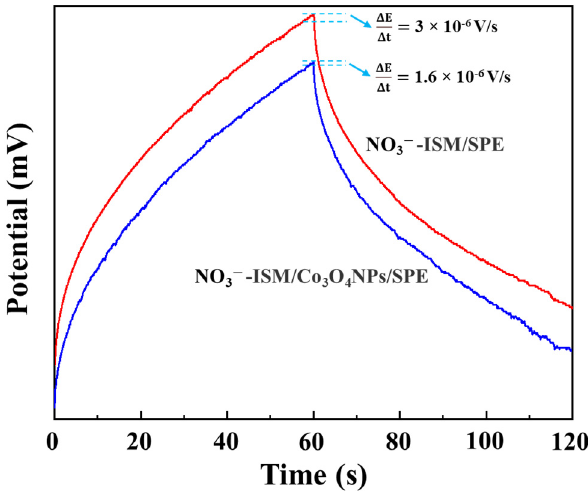
Figure 7. Chronopotentiograms for the NO 3 − -ISM/SPE (red) and NO 3 − -ISM/Co 3 O 4 NPs/SPE (blue) recorded in 0.01 M NaNO 3 solution by applying alternating currents of ±1 nA for 60 s.